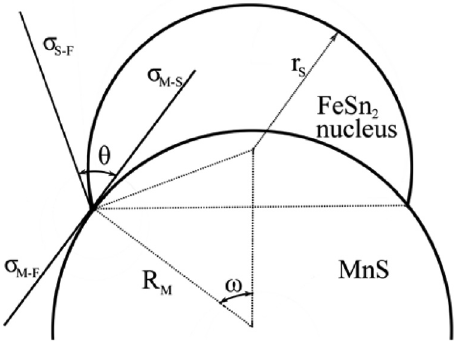
Fig. 3: Schematic illustration of FeSn 2 formation on